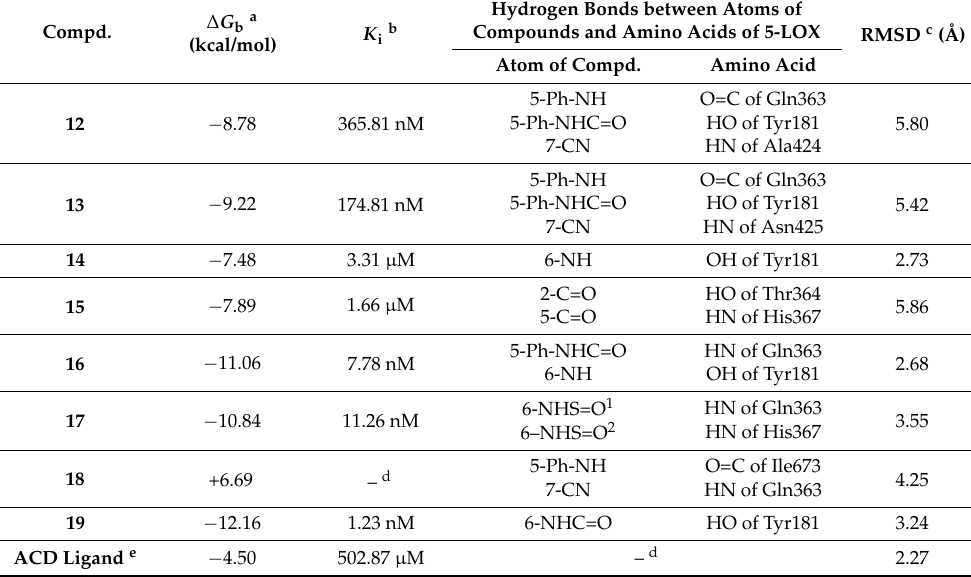
Table 5. Results of the flexible docking of compounds 12 – 19 into 5-LOX (pdb: 3o8y) [36] in comparison to the reference arachidonic acid (ACD).